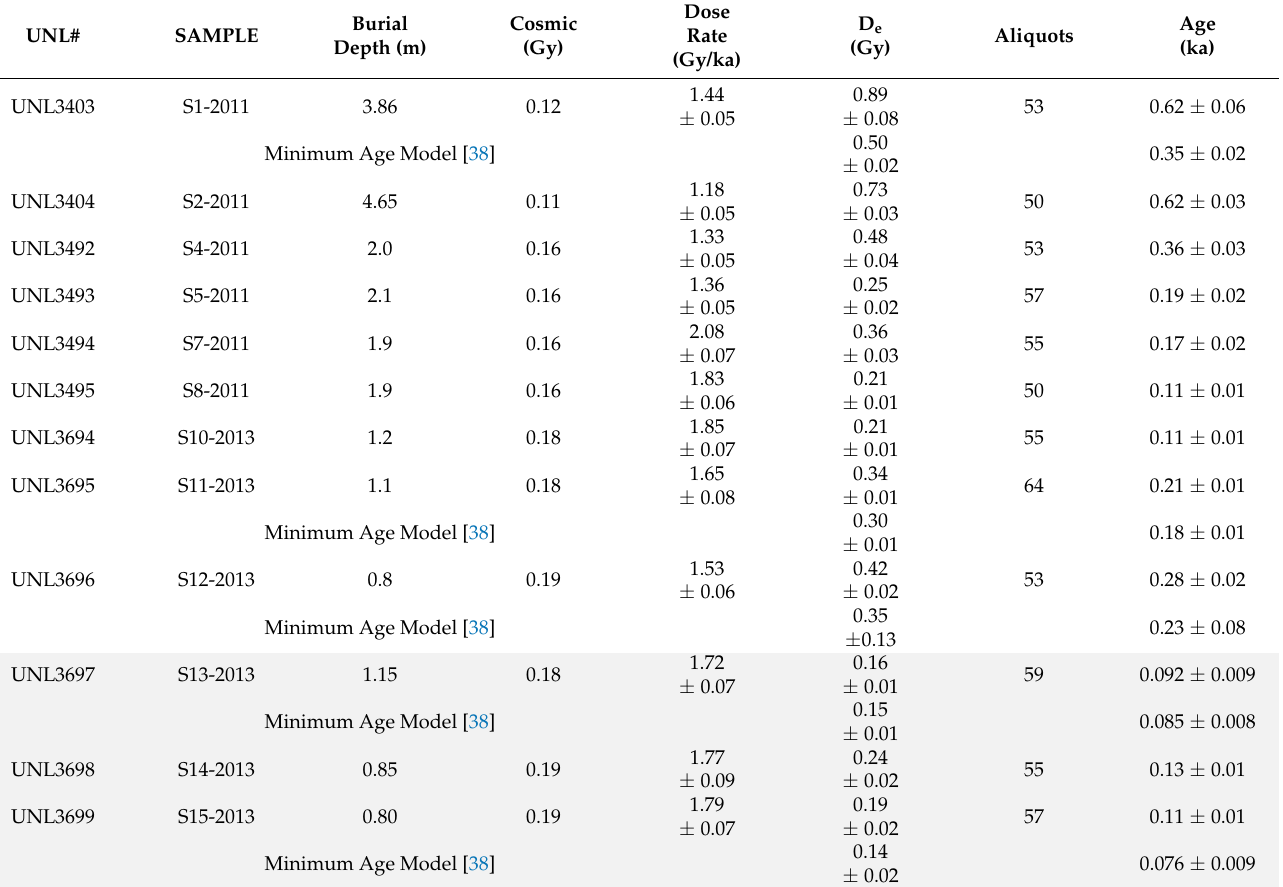
Table 2. Luminescence dating results. OSL ages are represented in years before 2011 or 2013, depending on the collection date specified in the sample name (second column). Shadowed rows represent samples collected within the dune, while white rows show the results for the beach sediment